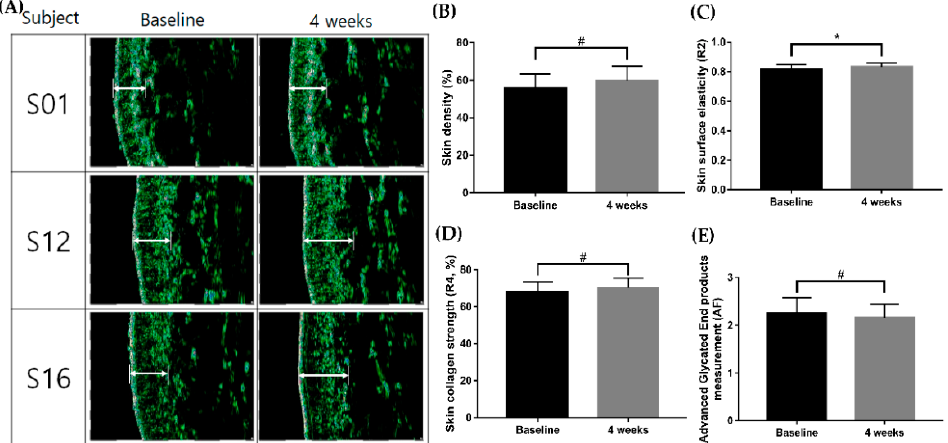
Figure 3. Comparison of skin density, skin surface elasticity, skin collagen strength, and the AGE measurement before and after 4 weeks of applying the CTP ampoule. Skin density, skin surface elasticity, skin collagen strength, and the AGE measurement were increased in response to applying the CTP ampoule over 4 weeks ( B – E ); # p < 0.001, Wilcoxon signed-rank test; * p < 0.001, paired samples t -test. The 4 week follow-up images taken with the Ultrascan UC22 (Courage + Khazaka electronic GmbH, Köhn, Germany) are shown in ( A ). CTP ampoule, Ever Collagen Corrector Collagen Tripeptide Ampoule; AGE, advanced glycated end